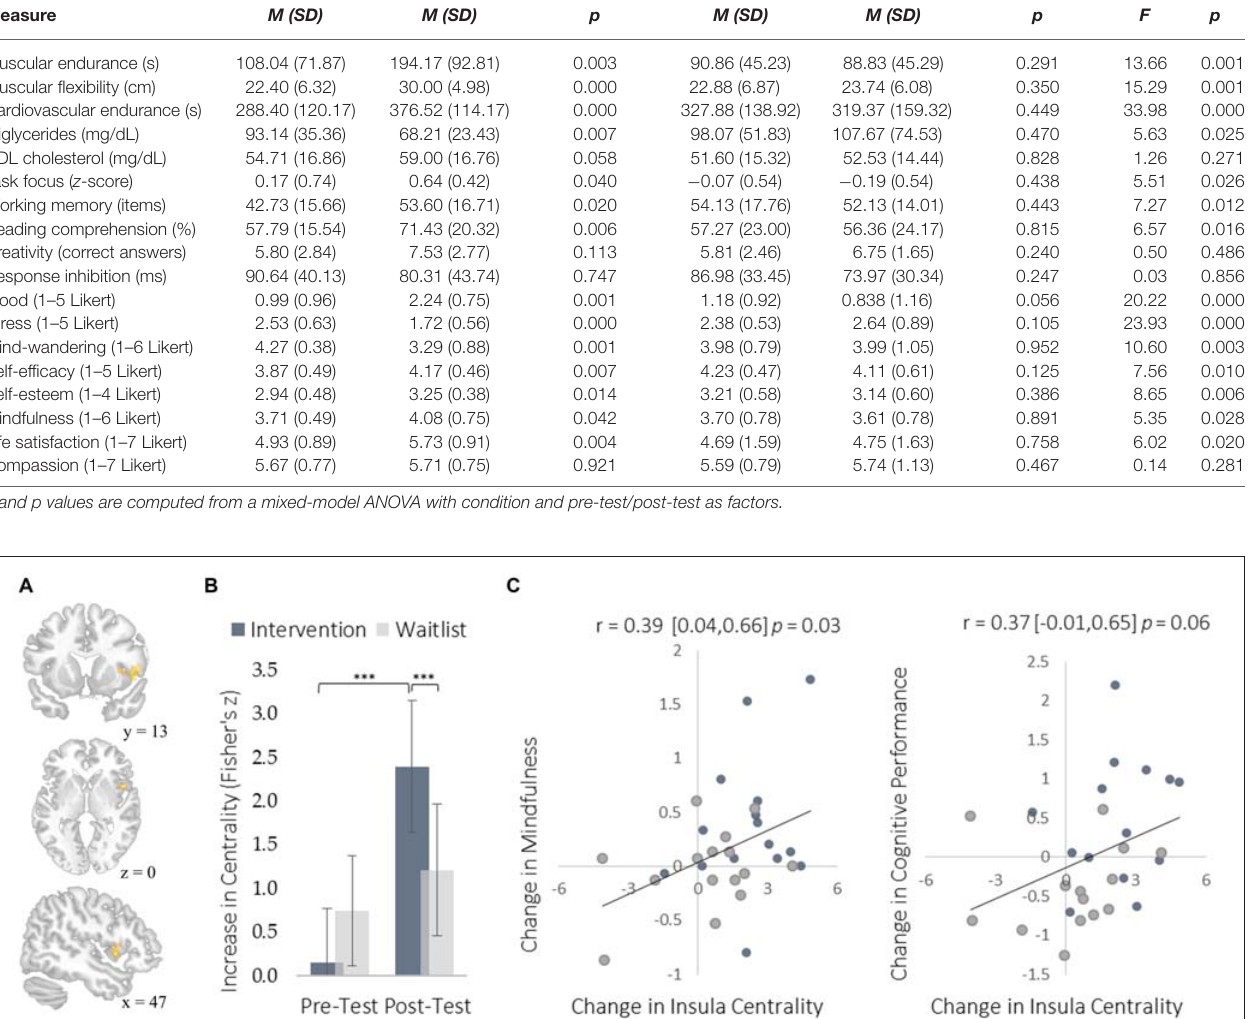
TABLE 1 | Means and standard deviations (SDs) for pre-test and post-test assessments. Intervention Waitlist control Pre-test Post-test Paired t -test Pre-test Post-test Paired t -test ANOVA